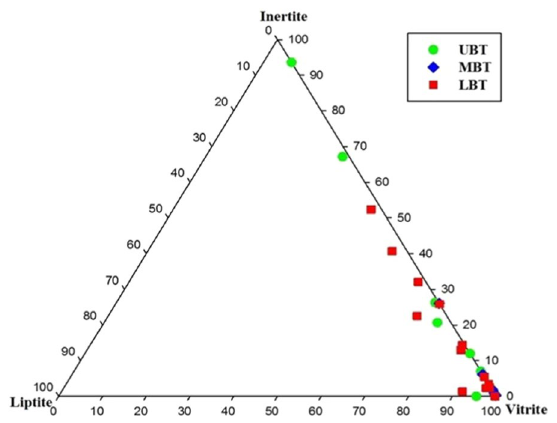
Fig. 5 Ternary plot for microlithotype monomaceral composition (samples 01 and 17 are excluded) (MBT samples may be masked by the LBT samples in bottom right